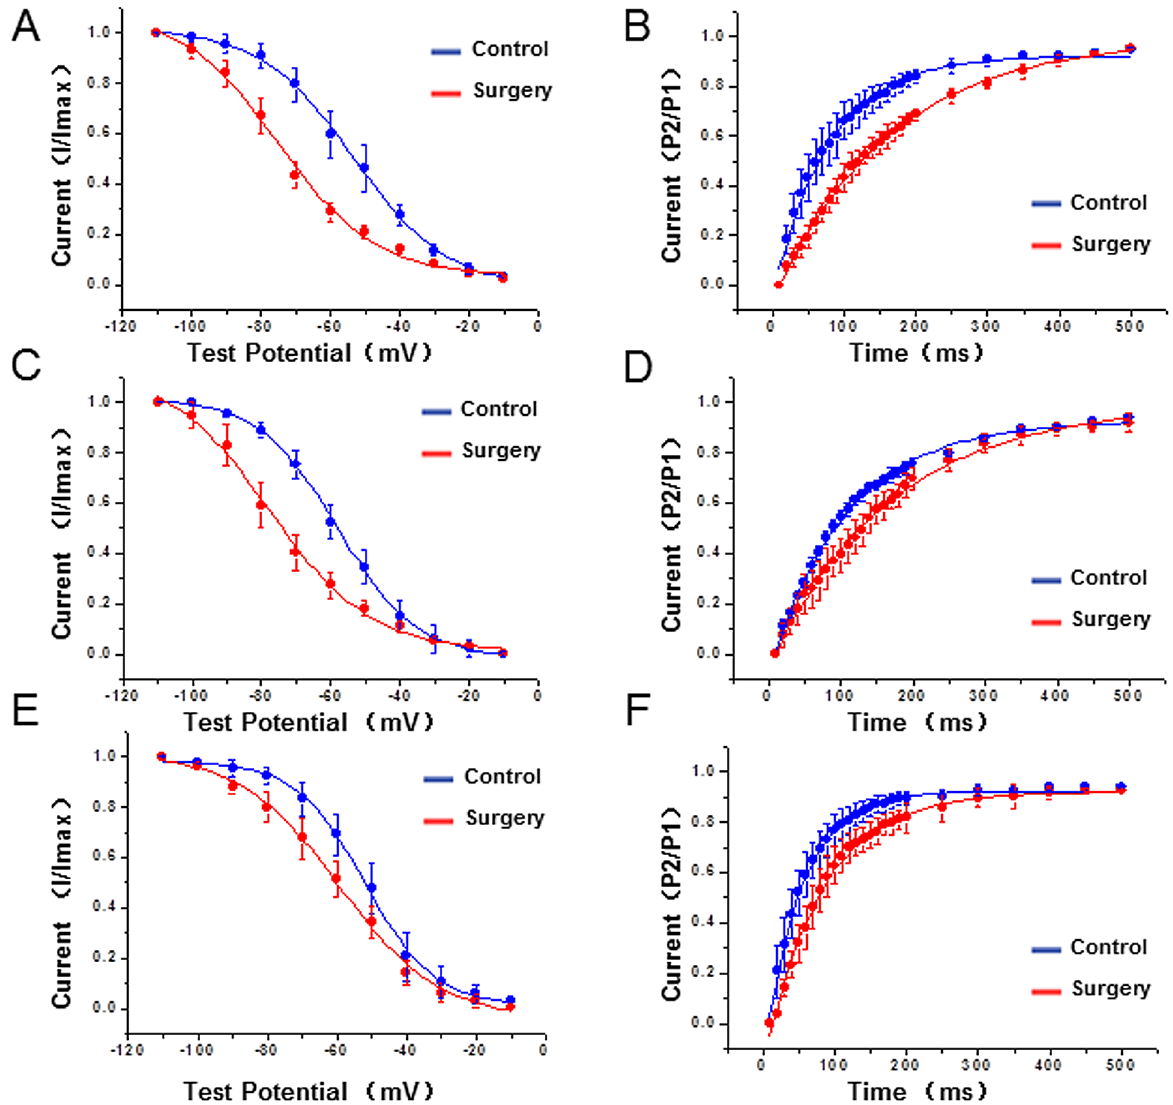
Fig 4. Characteristics of the steady-state inactivationcurves (A, C, E) and inactivationrecovery curves (B, D, F) of I to,f at different regions, including the epi-myocardium (A, B), endo-myocardium (C, D) and right ventricle(E, F) in both groups.